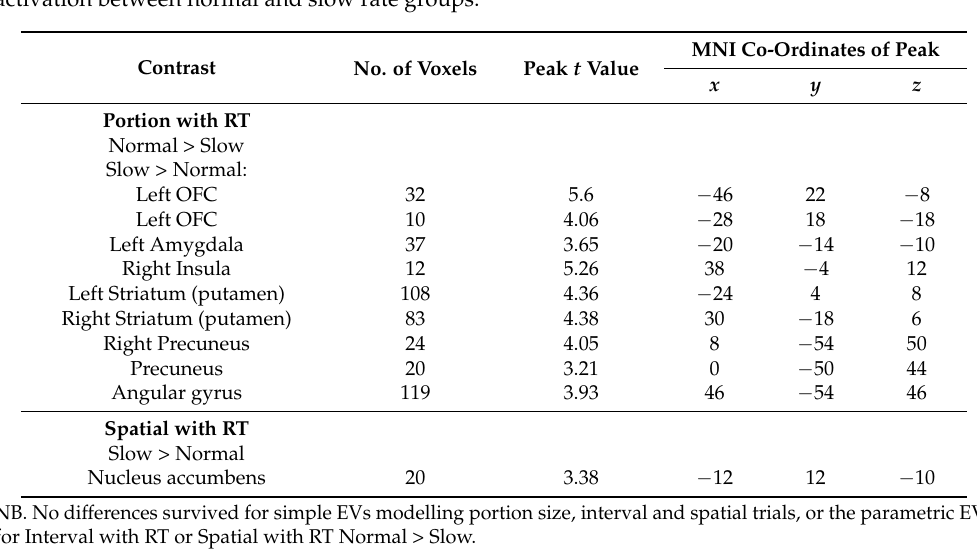
Table 4. Results of the masked neuroimaging analysis: size and peak co-ordinates of areas of differential activation between normal and slow rate groups.